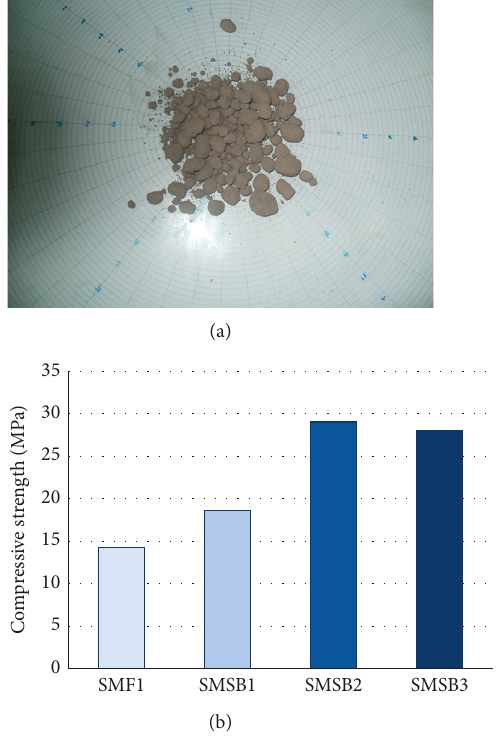
Figure 3: (a) Sample SMF2 after mixing and (b) compressive strength at the third day after